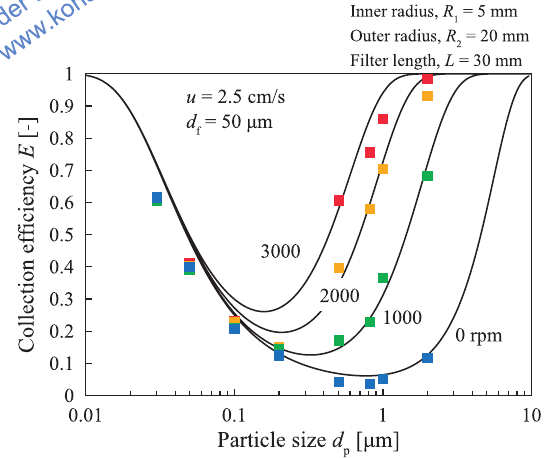
Fig. 10 Collection efficiency of centrifugal